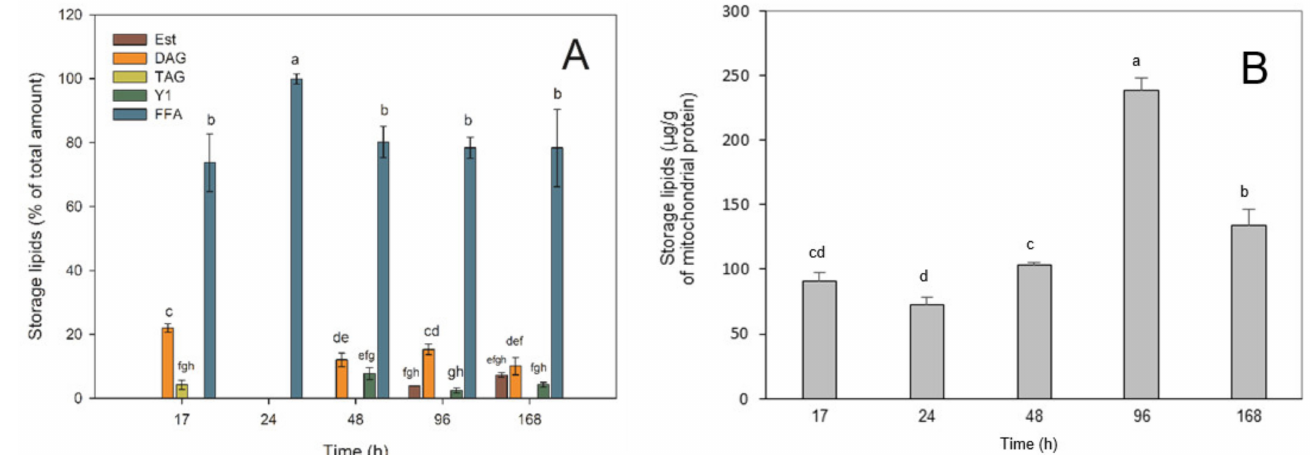
Figure 3. The storage lipid composition in E. magnusii yeast in the different growth phases during long-lasting cultivation. ( A )—the share of each storage lipid fraction,%; TAGs—triacylglycerols; DAGs—diacylglycerols; FFAs—free fatty acids; ESt— sterol esters; Y1—unknown fraction ( B )—the share of each storage lipid fraction (mg/g). a − h Means with the same letter did not differ significantly. Values are mean ± S.E.M from three independent experiments and three analytical replicates.